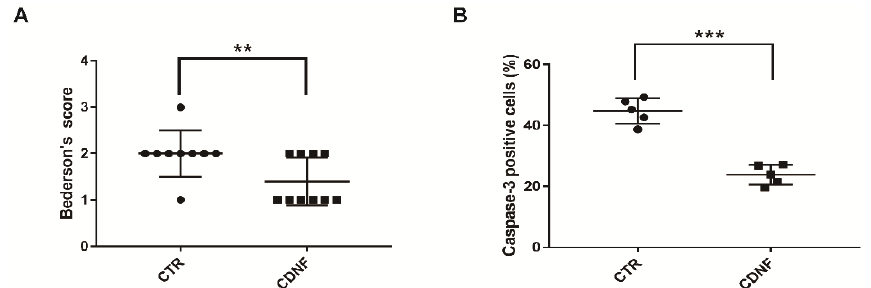
Figure 2. The local cortical CDNF pretreatment significantly reduced neurological scores and cell apoptosis in MCAO rats. ( A ) CDNF pretreatment significantly reduced the Bederson score (control group, n = 8; CDNF group, n = 10). ** p < 0.01 versus CTR by Mann-Whitney u test. ( B ) Quantitative analysis of the number of caspase-3 positive cells in the cortexes (control group, n = 5; CDNF group, n = 5). *** p < 0.001 versus CTR. Student’s t -test. Data are expressed as the mean ±